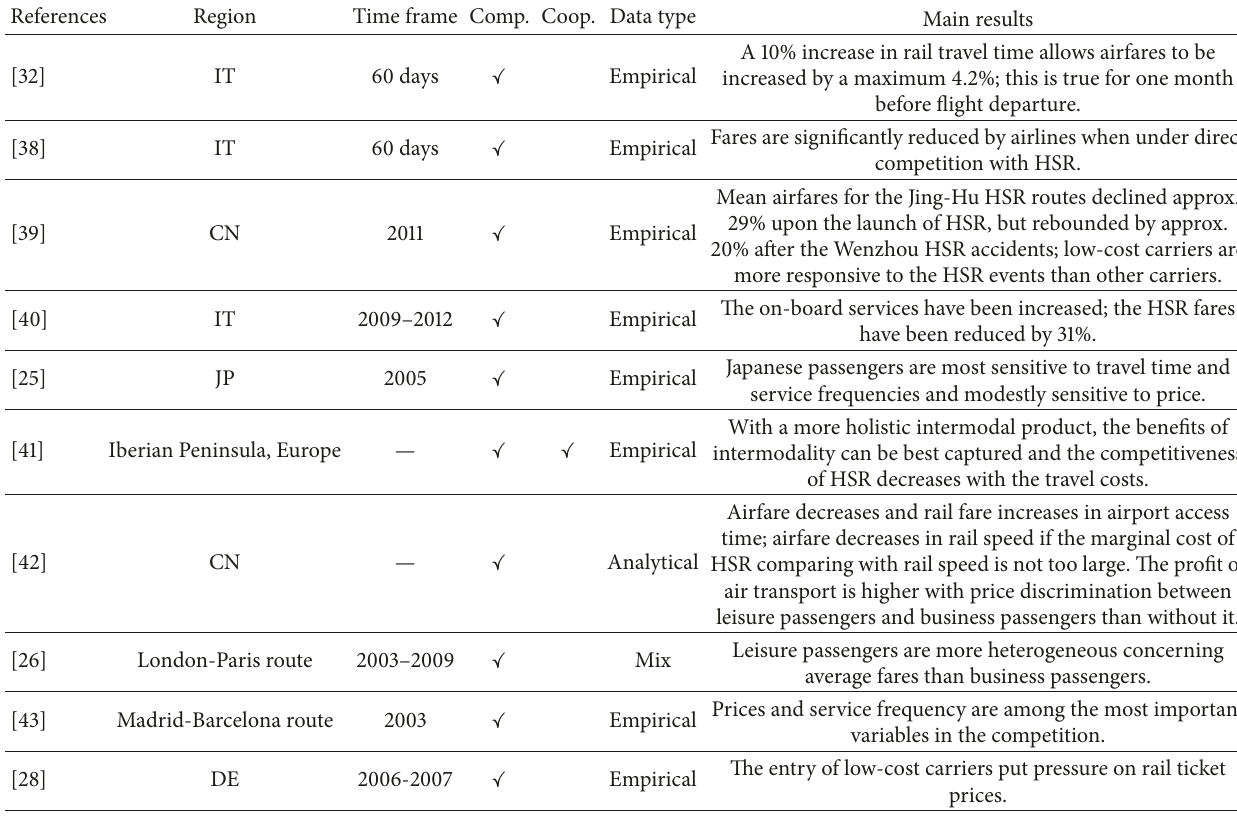
Table 7: The competition and cooperation effects between air transport and HSR on price.